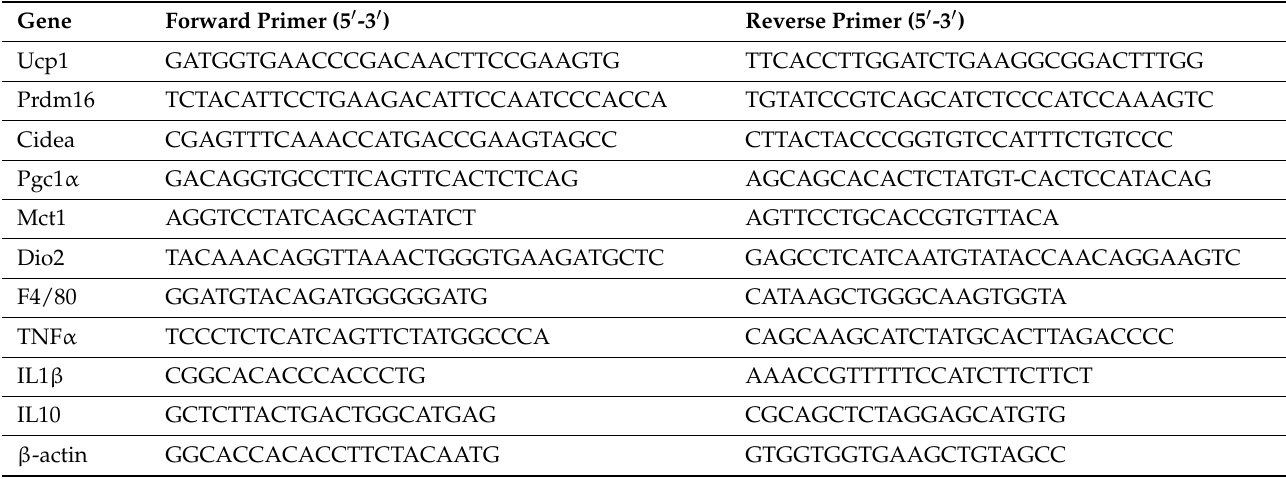
Table 1. Sequences of the gene-specific